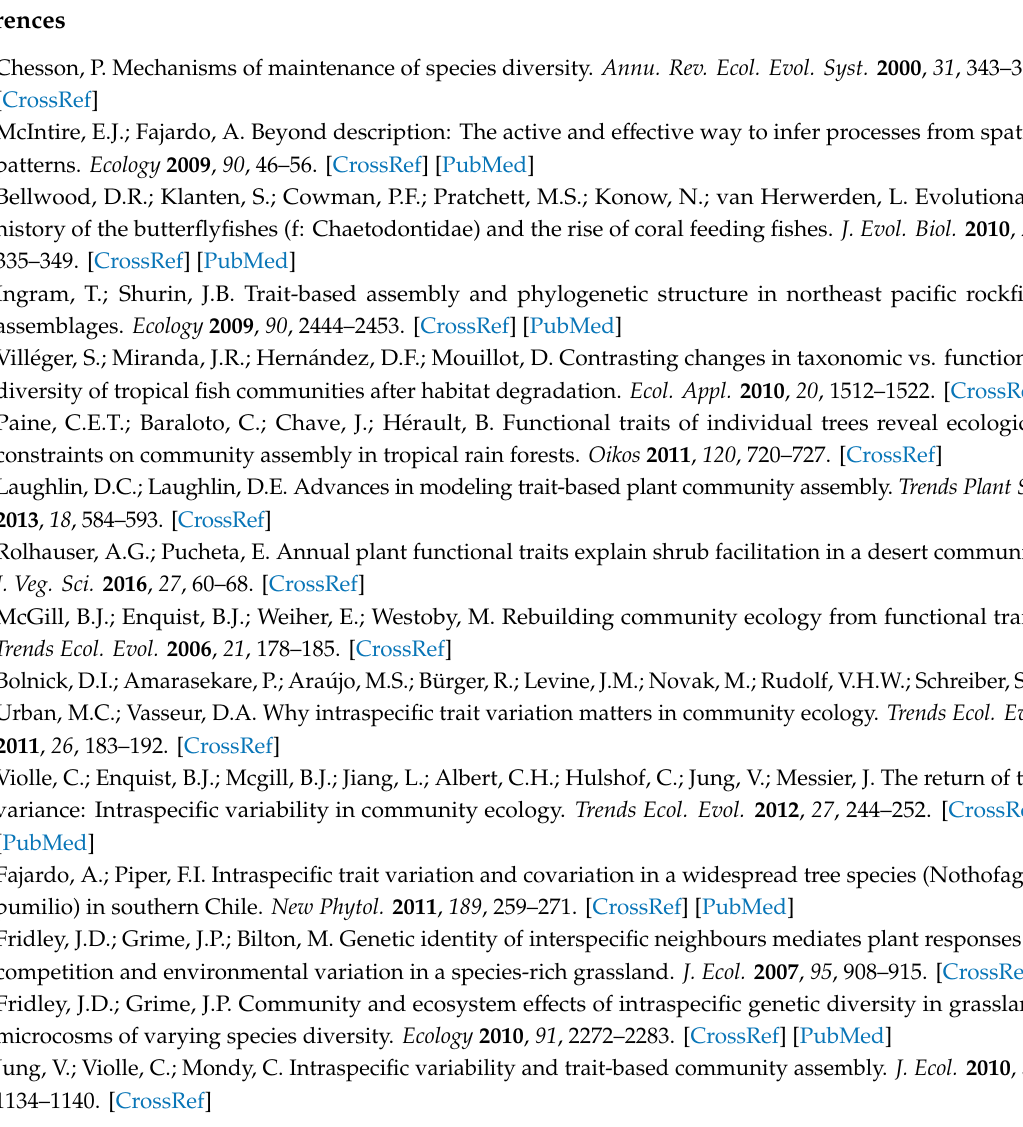
Figure S1: Landscape vegetation distribution, Figure S2: Influence of environmental heterogeneity on functional alpha diversity, Figure S3: Influence of environmental heterogeneity on functional beta diversity, Figure S4: Influence of environmental heterogeneity on functional beta diversity, Table S1: Soil factors and species richness of each plot, Table S2: The species of this study, Table S3: PCA loadings of each functional trait on PCA 1 axis and PCA 2 axis, Table S4: PCA loadings of each soil factors on PCA 1